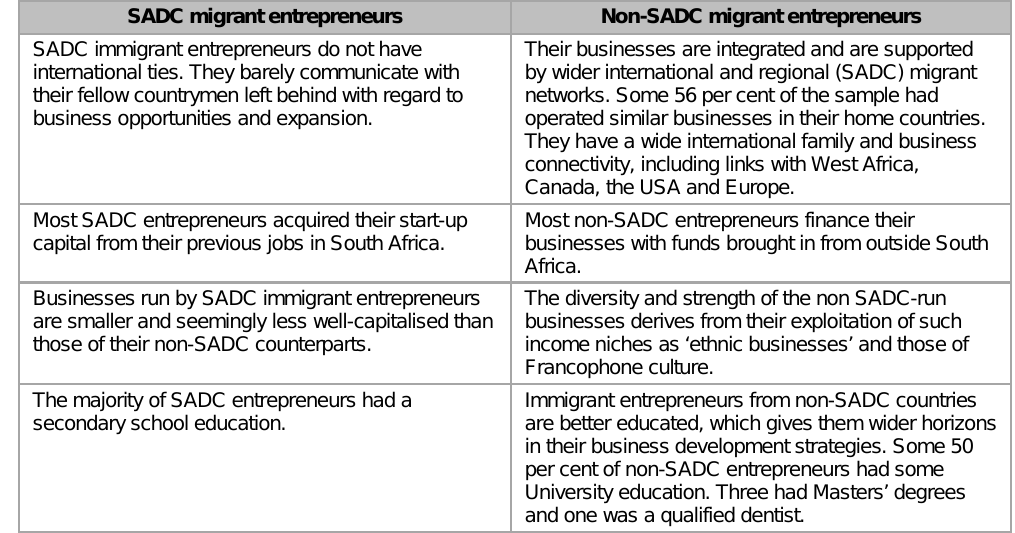
Differences between SMMEs run by SADC and non-SADC migrants SADC migrant entrepreneurs Non-SADC migrant